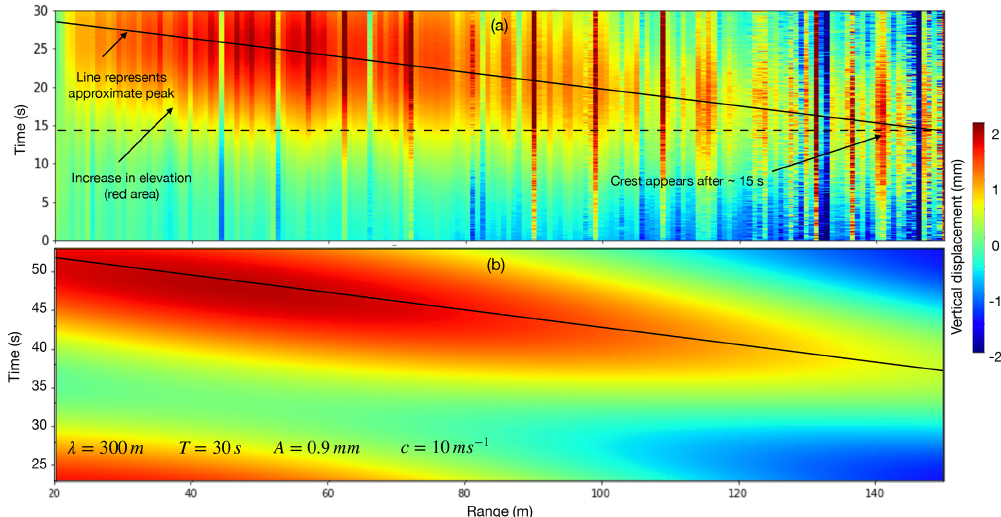
Figure 5. (a) Phase-derived vertical displacement over 30s at 21:56UTC. The displacement is displayed in the range-time space along one fixed direction. Transient features are thus expected to have a diagonal nature, where the angle represents the velocity of the feature. (b) Modeled displacement of a similar wave as in panel (a) .